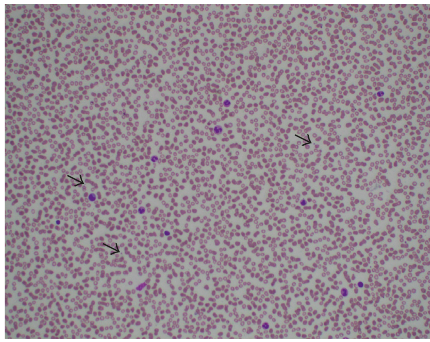
Figure 1: A Wright–Giemsa stained peripheral blood film of the patient under 200x microscopic magnification showing absence of platelet clumping. Scattered platelets are seen next to blue arrows with no